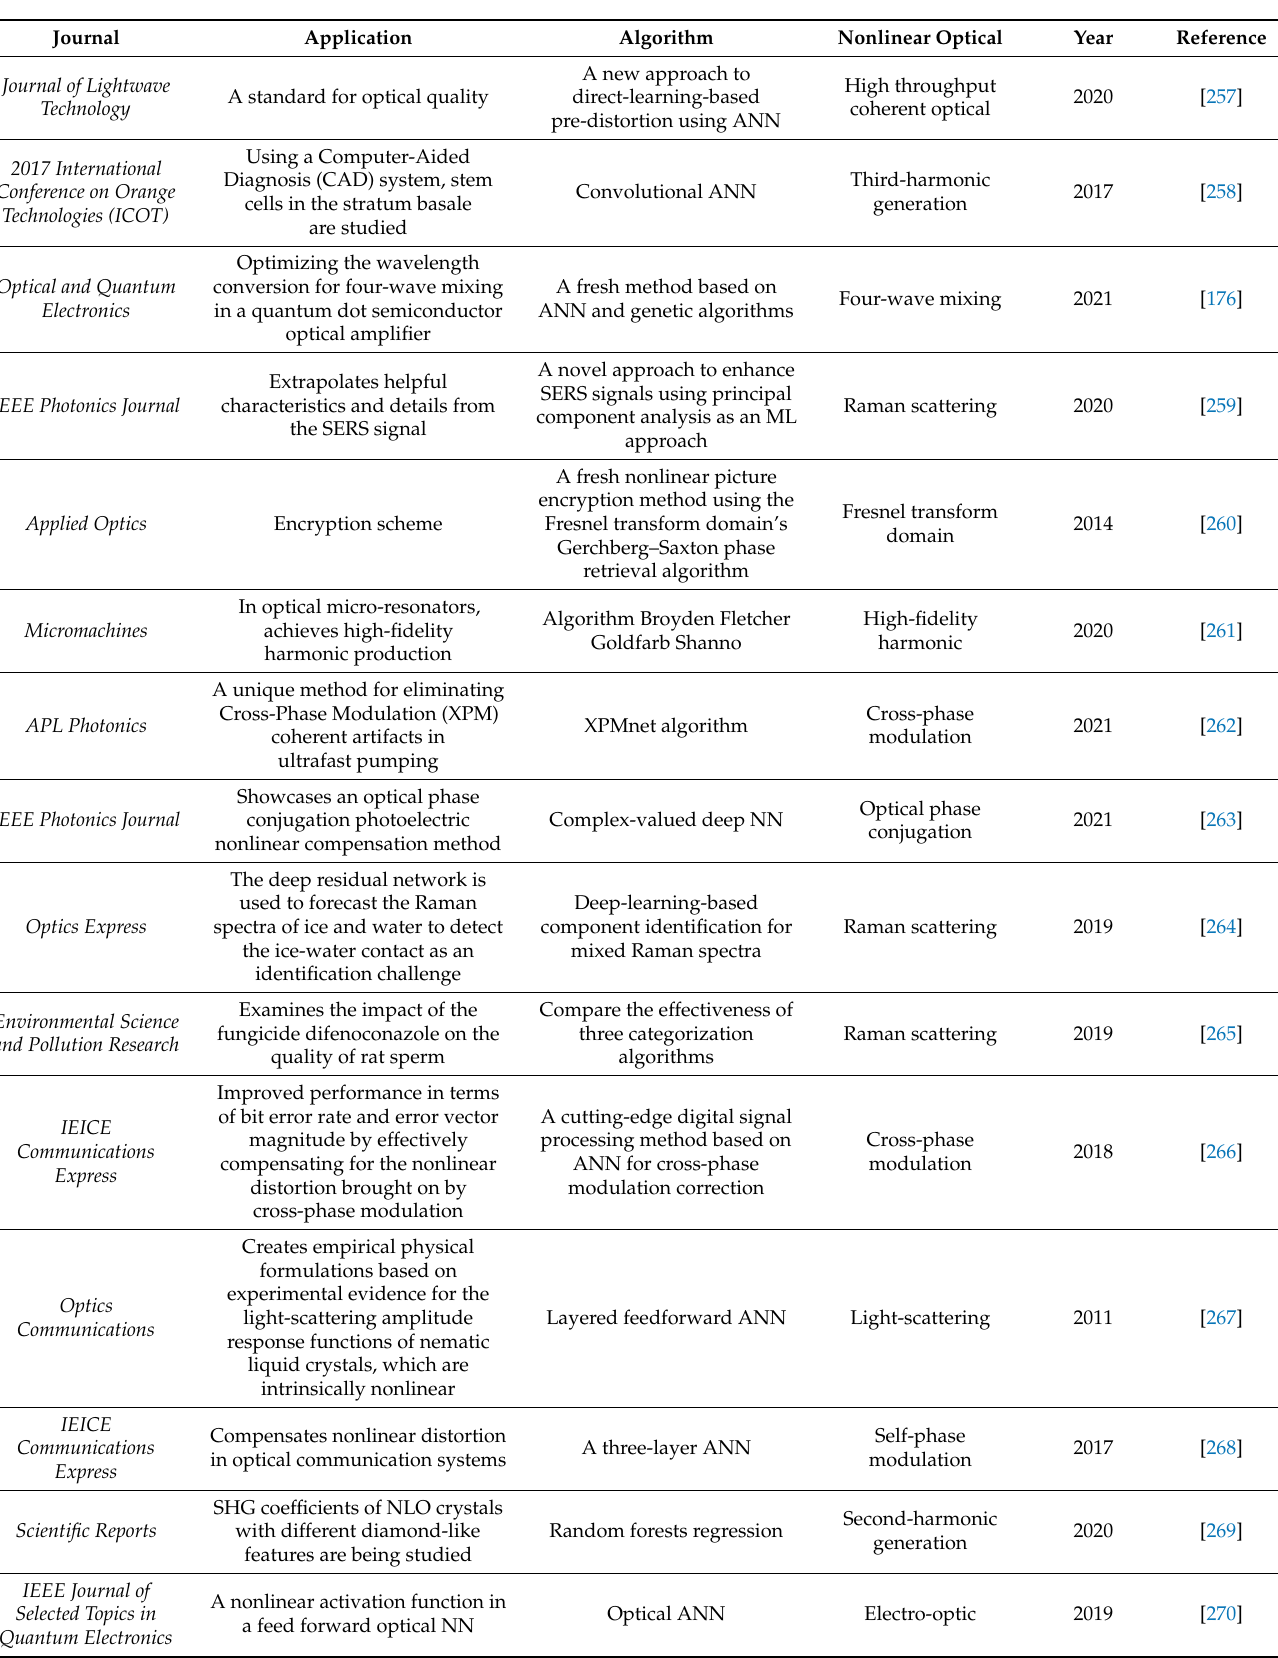
Table 4. Publications about NLO processes assisted by